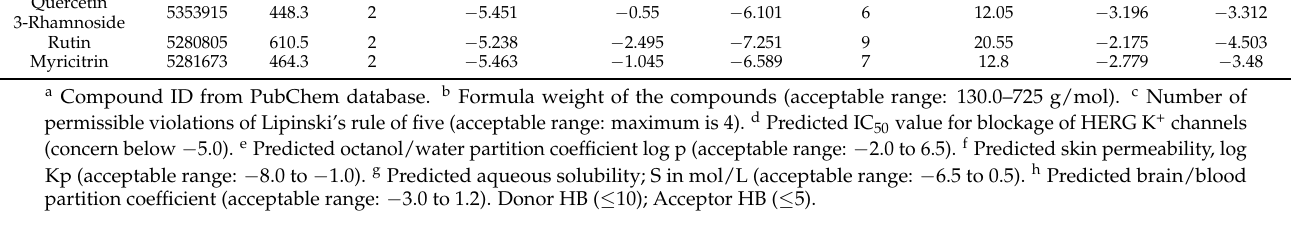
Table 2. Toxicity analysis of the selected compounds predicted by AdmetSAR.